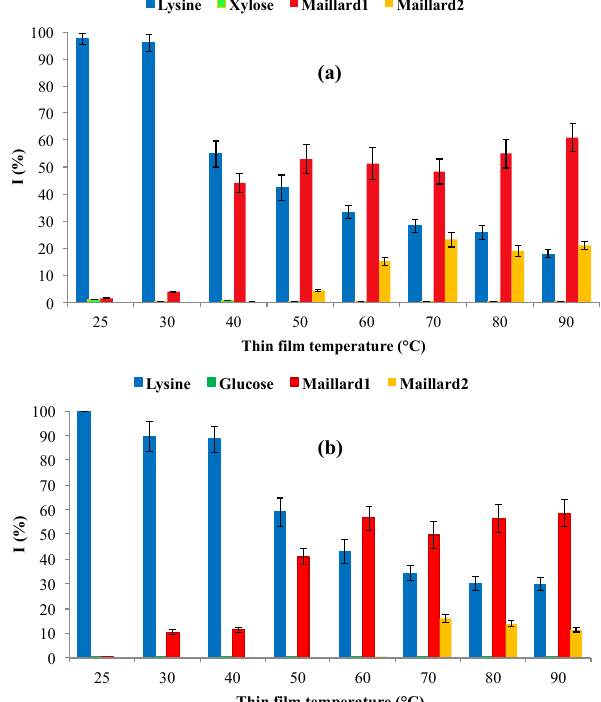
Figure 5. The reactants and Maillard reaction products (%) versus thin film temperatures °C. ( a ) L-lysine/D-xylose mixtures and ( b ) L-lysine/D-glucose mixtures.